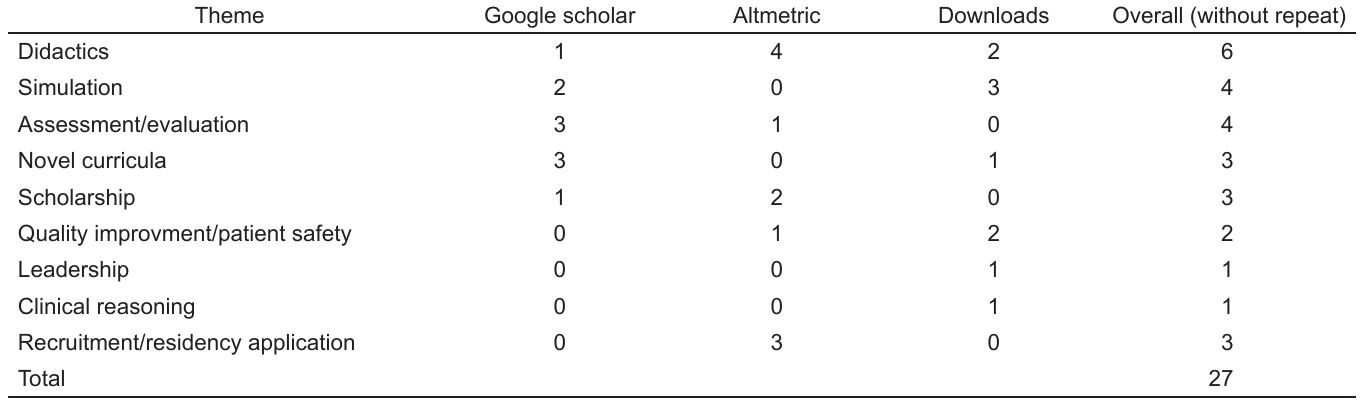
Table 3. Topics of the Western Journal of Emergency Medicine Special Issue top 10 articles from